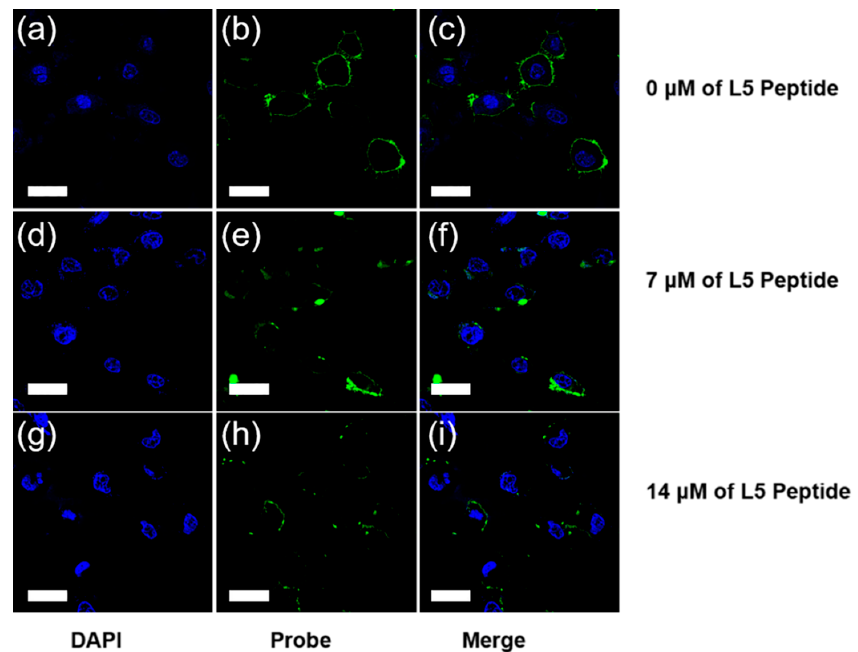
Figure 3. Confocal microscopy images of Hep-G2 cells pretreated with different amounts of peptides L5 prior to NDSA-L5 treatment. ( a – c ) The imaging of Hep-G2 cells incubated with the 0 µ M of L5 peptide solution; ( d – f ) the imaging of Hep-G2 cells incubated with the 7 µ M of L5 peptide solution; ( g – i ) the imaging of Hep-G2 cells incubated with the 14 µ M of L5 peptide solution Scale bar, 20 µ m. The specific target ability of NDSA-L5 was also verified by the flow cytometry experi- ment for the GPC-3 protein of cancer cells. After incubation with NDSA-L5, hepatocellular carcinoma cells (Hep-G2, Huh-7, Hep-3B cells) over-expressing the GPC-3 protein were found to be clearly fluorescent, while hepatocellular carcinoma cells (LM3 cells) with low- expressing GPC-3 protein showed weak fluorescence signals (Figure 4a–d).